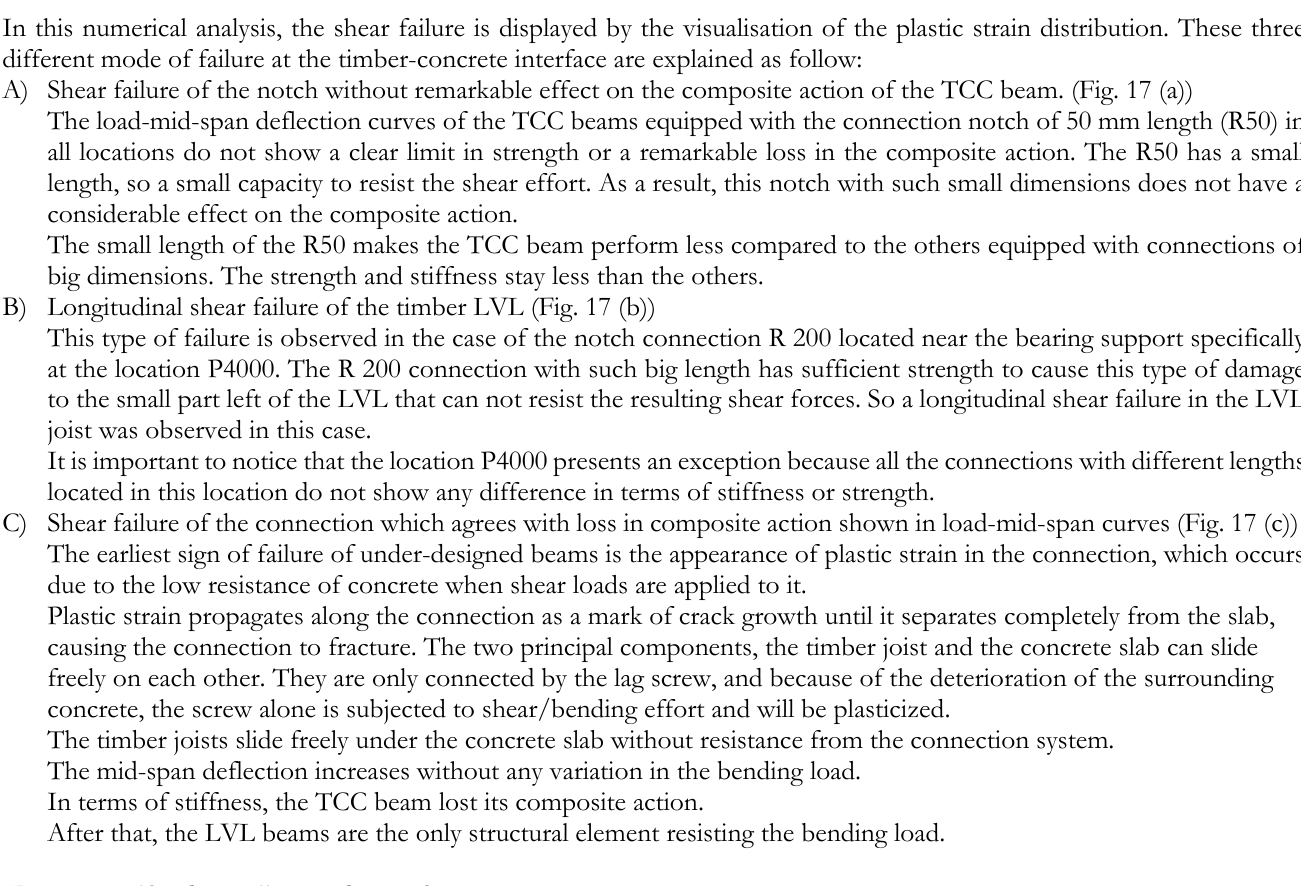
Figure 17: Plastic strain distribution show shear failure of the connection: (a) R 50 at position 2m, (b) in timber for R200 located at 04 m and(c) shear failure of R100 Located at 3